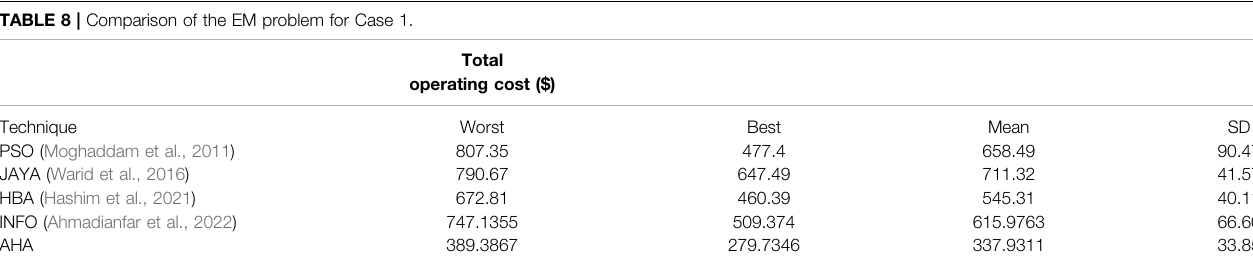
TABLE 8 | Comparison of the EM problem for Case